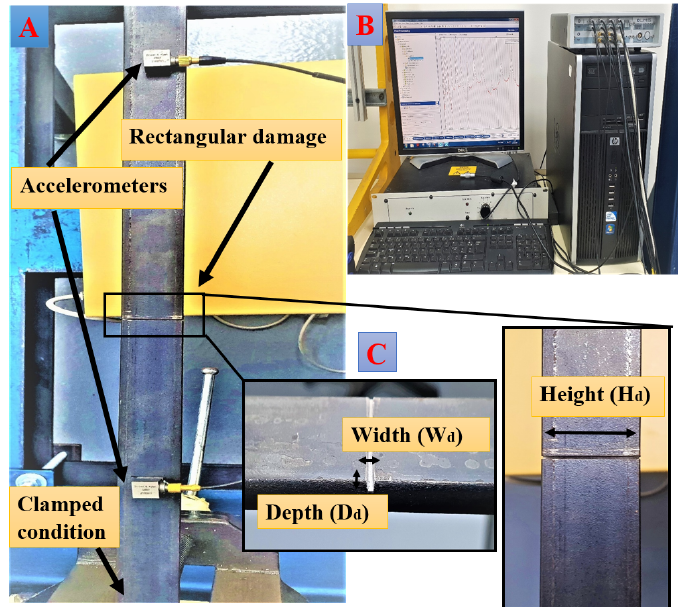
Figure 16. Experimentally tested cantilever beam where A shows experimental set up and input/output measurement points with accelerometers; B displays acquisition card and software; C shows details on the rectangular